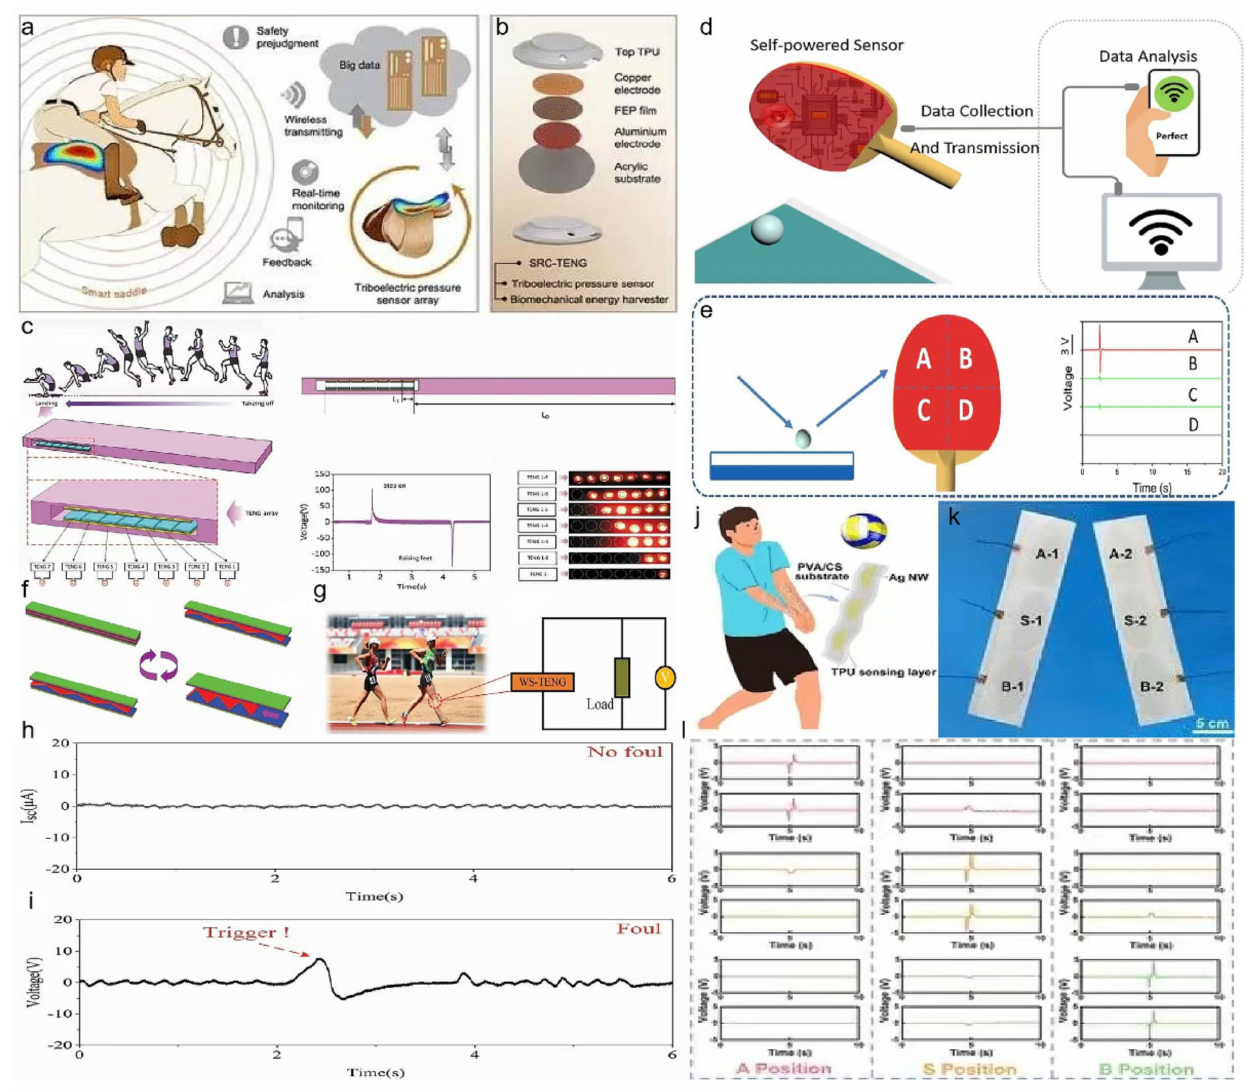
Figure 3. ( a ) Concept diagram of intelligent saddle mounted on horse, which is used to collect information and energy. ( b ) Structural design sectional view of SRE-TENG. ( a , b ) Reprinted with permission from Ref. [81]. Copyright 2022 American Chemical Society. ( c ) Schematic diagram of long jump monitoring system with its own power supply, electrical signal generated by CC-TENG and schematic diagram of self-powered reaction system. Reprinted with permission from Ref. [82]. Copyright 2022 Informa UK Limited. ( d ) Experimental design of big data analysis of the intelligent sensor with its own power supply in table tennis training. ( e ) The device for playing table tennis is integrated with four sensor units. The illustration shows the real-time three electric signals of the four sensor units. ( d , e ) Reprinted with permission from Ref. [83]. ( f ) WS-TENG workflow. ( g ) Pictures of athletes’ walking competition. ( h ) The voltage signal of WS-TENG when there is no foul in the walking competition. ( i ) The voltage signal of WS-TENG when an athlete commits a foul in the walking competition. ( f – i ) Reprinted with permission from Ref. [87]. Copyright 2022, Informa UK Limited. ( j ) A 2 × 3 schematic diagram of integrated electronic skin array on both arms. ( k ) Display photos of 2 × 3 integrated electronic skin array. ( l ) The real-time output voltage signal when the volleyball impacts the different positions of the electronic skin array. ( j – l ) Reprinted with permission from Ref. [88]. Copyright 2021, American Chemical